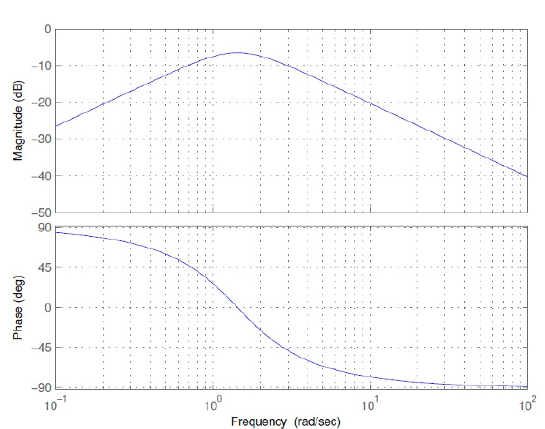
Figure 12. Frequency response of the self-zero integrator (from